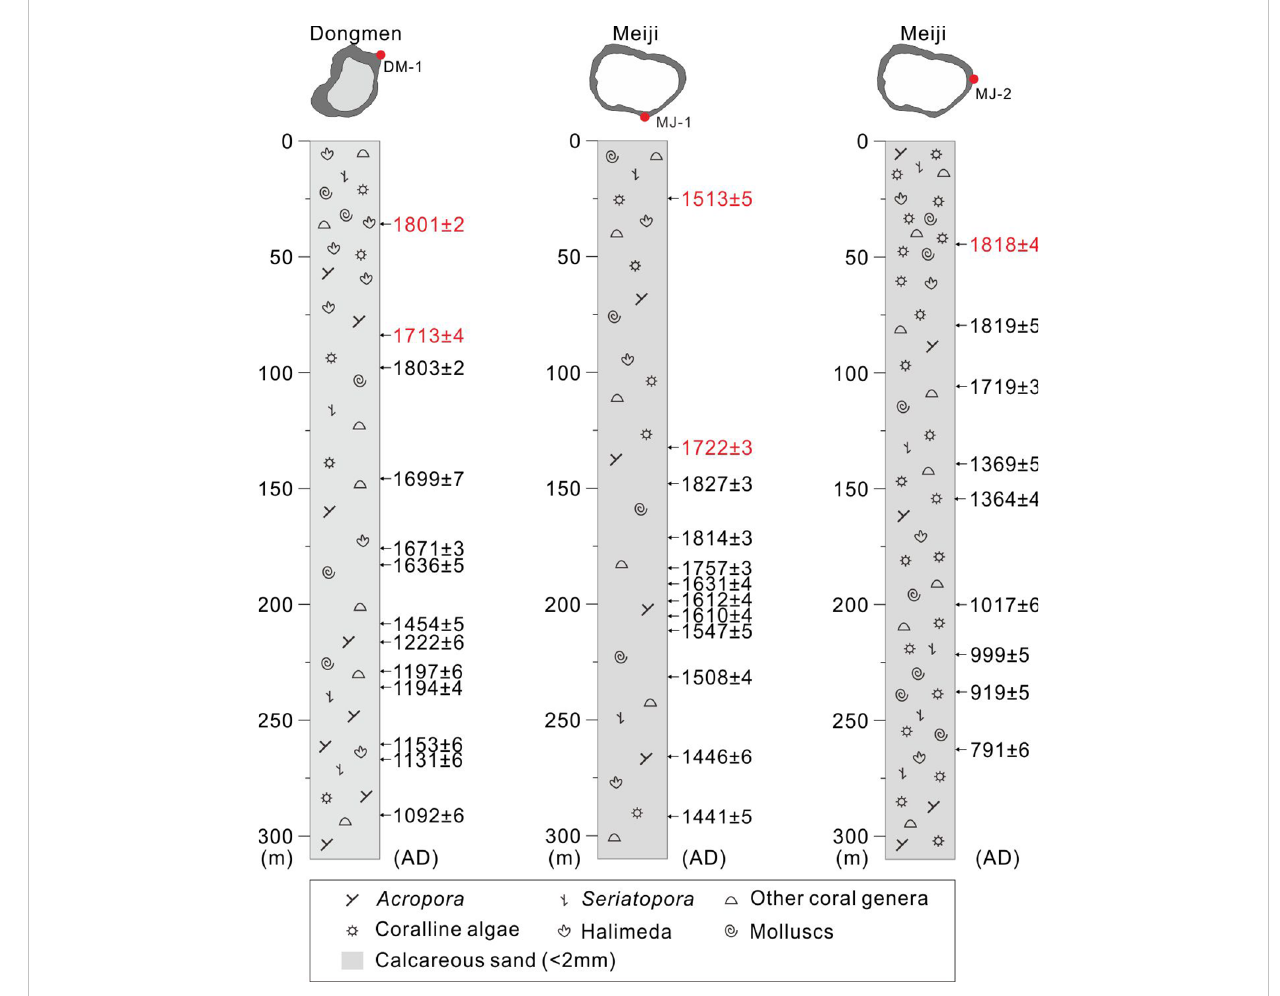
FIGURE 3 Core logs, bio-sedimentary facies, and U-Th chronology. The abnormal U-Th ages in the upper parts of cores are labelled in